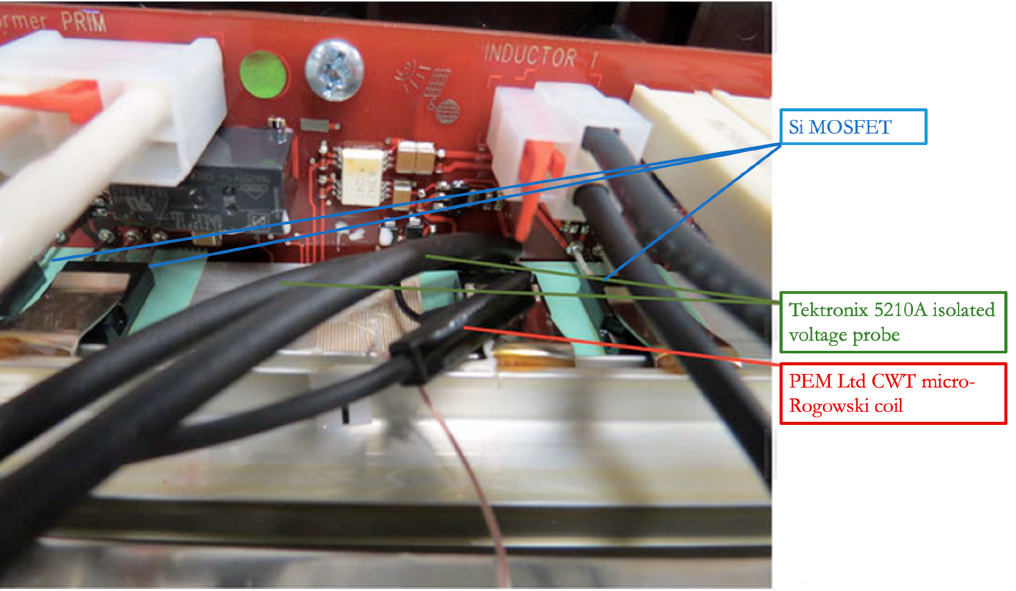
Figure 3. Measurement setup for switch measurements. A single MOSFET in the inverter H-bridge is monitored via isolated voltage probes and a micro-Rogowski current monitor.